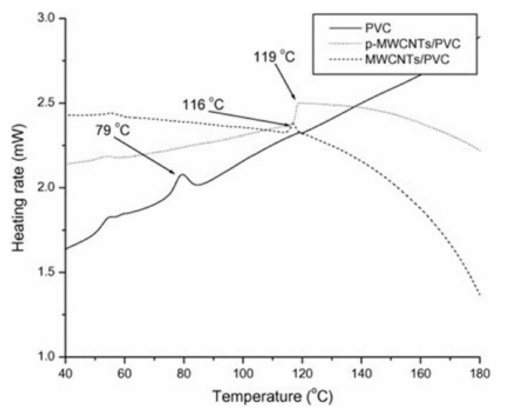
Figure 5. The Tg values on the DSC thermogram of the cooling run of PVC and PVC/MWCNT nanocomposites